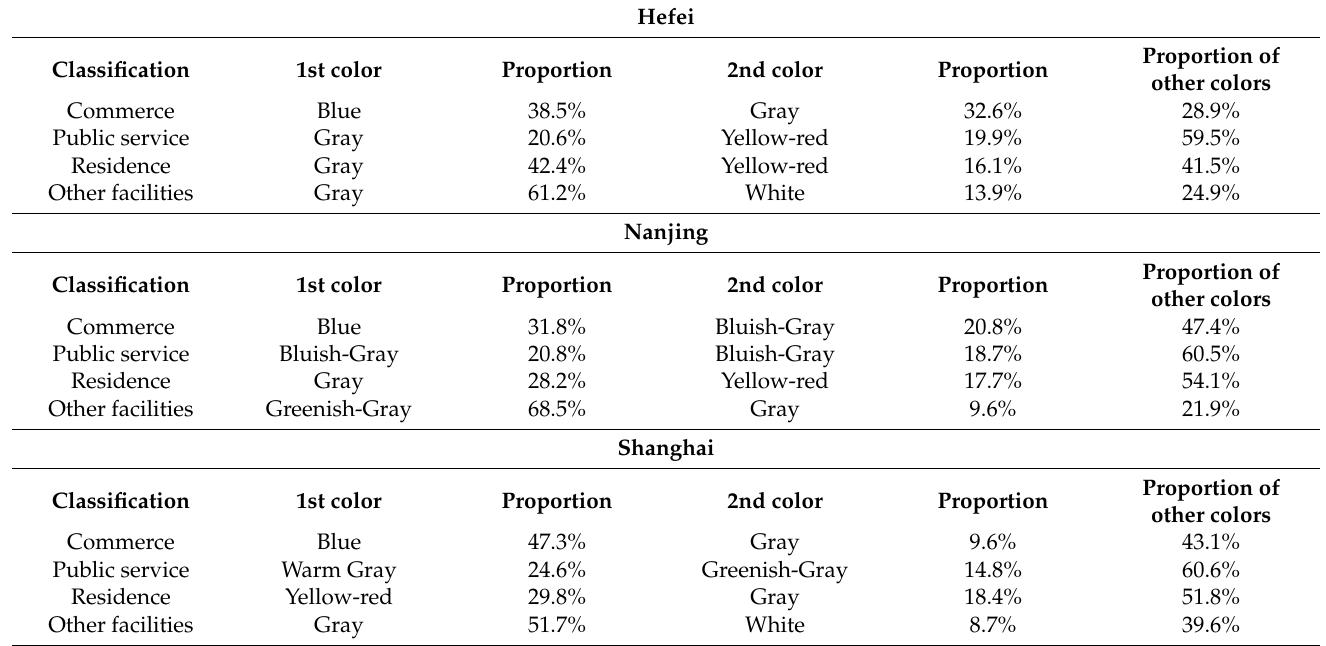
Figure 14. Mapping the building function of Hefei, Nanjing, and Shanghai. Table 8. The statistical results of façade color on building classification in the three study